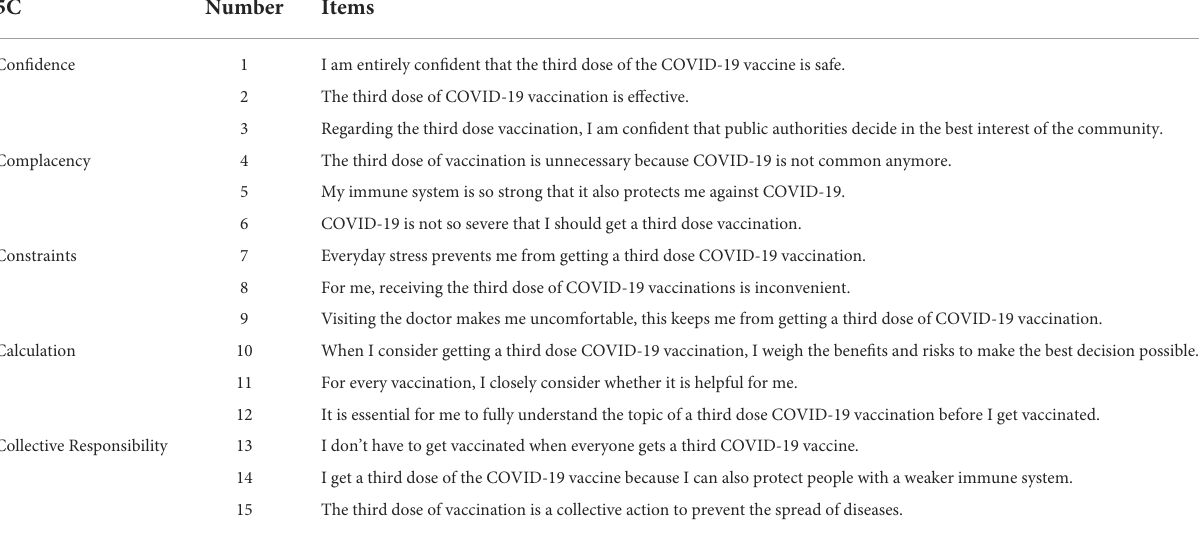
TABLE 1 Items of 5C scale measuring psychological antecedents of the third dose of COVID-19 vaccine. 5C Number Items Confidence 1 I am entirely confident that the third dose of the COVID-19 vaccine is safe. 2 The third dose of COVID-19 vaccination is effective.